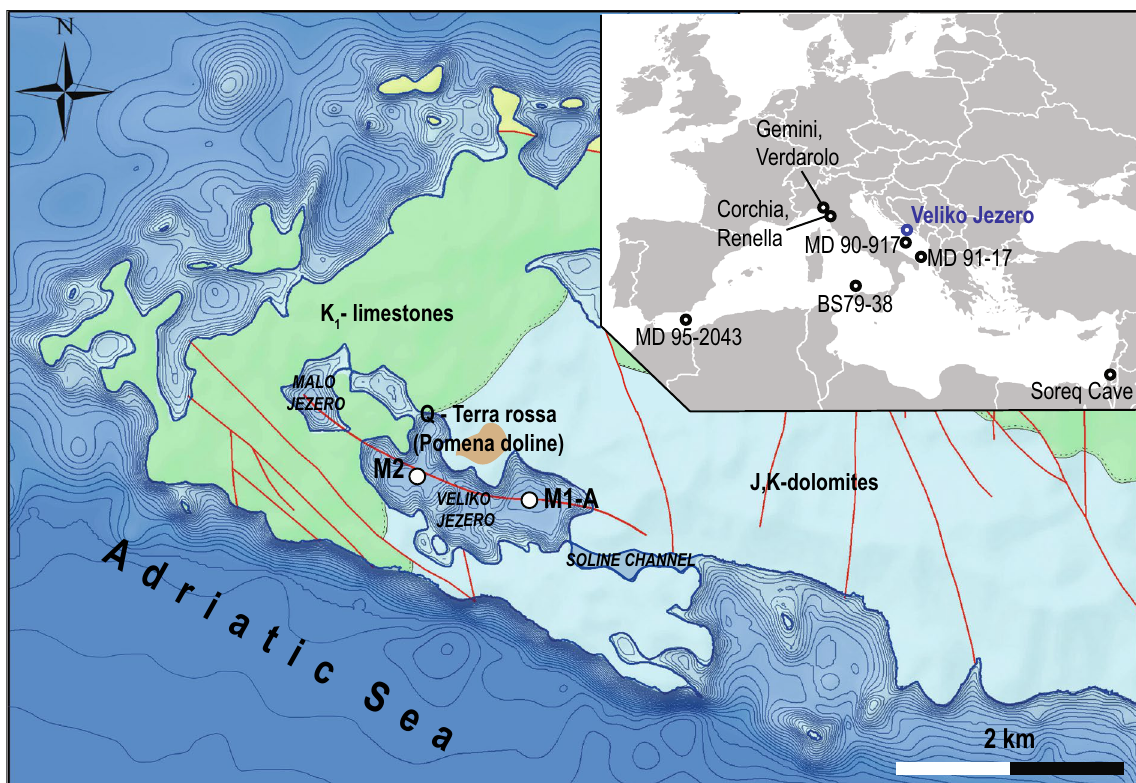
Figure 1. Location of Lake Veliko jezero and Mediterranean climate records (as discussed in the text) in the upper right corner with the locations of Cores M1-A and M2 and the stratigraphical and lithological surroundings of Lake Veliko jezero. Map was created using the ESRI ArcInfo 10.2.1 GIS software (https:// www. esri.